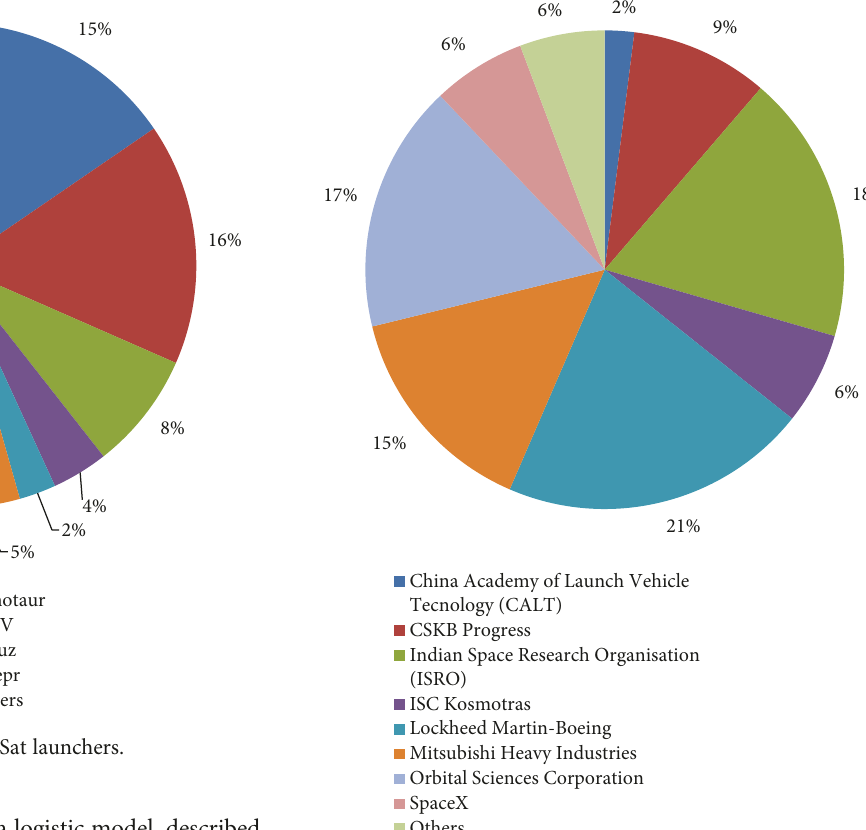
Figure 17: Main CubeSat launchings